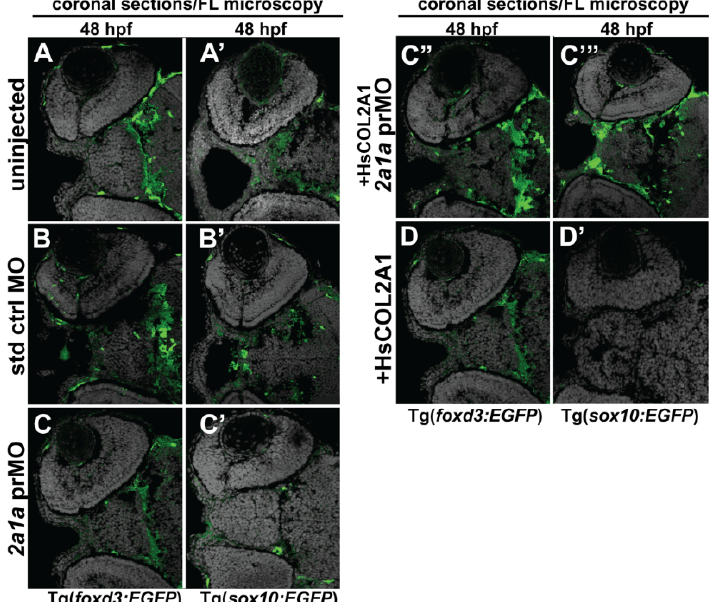
Figure 6. Col2a1a MO knockdown differentially affected ocular neural crest cell Sox10 and Foxd3 expression during early eye development. FL microscopy analysis of the effects of Col2a1a knock- down on GFP reporter expression in transverse cephalic sections from 48 hpf Tg ( foxd3::EGFP ) and Tg( sox10::EGFP ) transgenic zebrafish embryos injected at the single-cell stage with a lissamine- tagged antisense prMO targeting col2a1a . MO knockdown of Col2a1a adversely affected Sox10-pos- itive GFP expression in ocular anterior segment neural crest cells ( A’ – C’ ). The Foxd3-positive GFP expression in ocular neural crest cells was not affected by Col2a1a knockdown ( A – C , C” , D ). The coinjection of human (Hs) COL2A1 protein rescued Sox10-positive GFP expression ( C’’’ ), while the injection of HsCOL2A1 alone ( D’ ) adversely affected ocular Sox10-positive GFP expression in neural crest